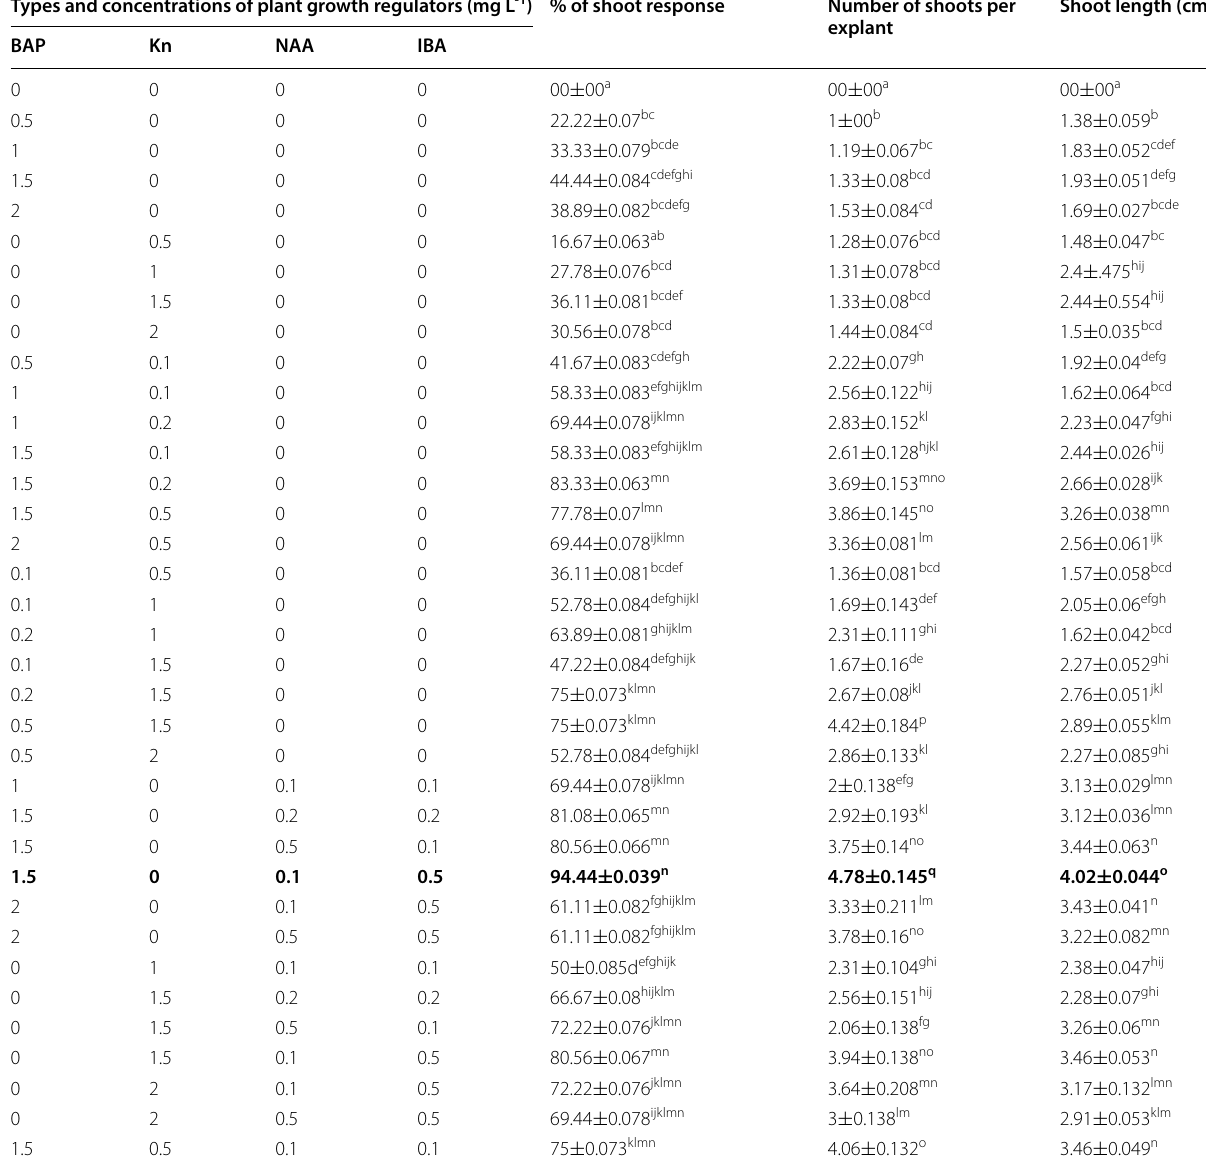
Table 2 The effects of different cytokinins and auxins on initiation and growth of shoots from shoot tips using the full strength of Murashige and Skoog medium of Artocarpus heterophyllus